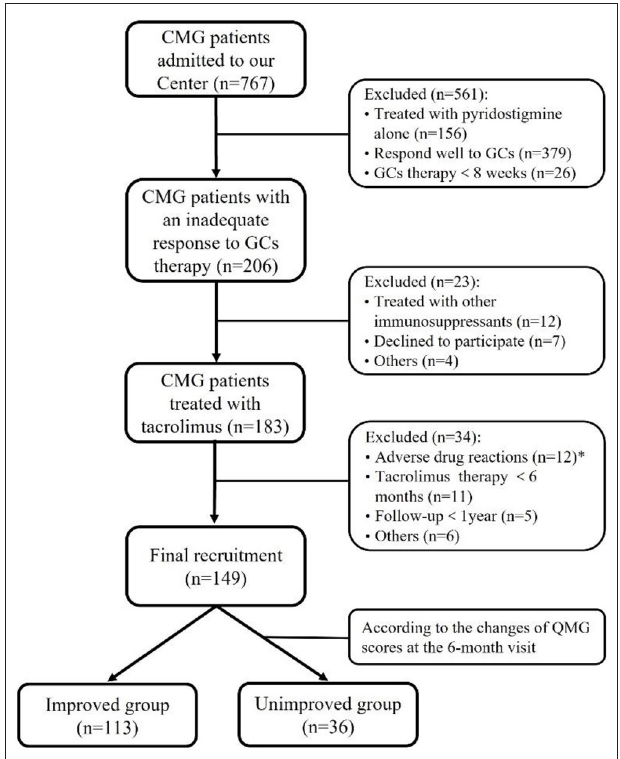
FIGURE 1 | Flowchart of participants’ recruitment. *During the follow-up throughout our study, 12 out of 183 ( < 7.5%) patients discontinued tacrolimus due to severe adverse drug reactions after a median of 2.8 months (ranged from 0.25 to 10.00 months): renal insufficiency in three, hepatic dysfunction in two, stomachache in two, tremor in two, hyperglycemia in one, infection in one, and allergic to tacrolimus in one.